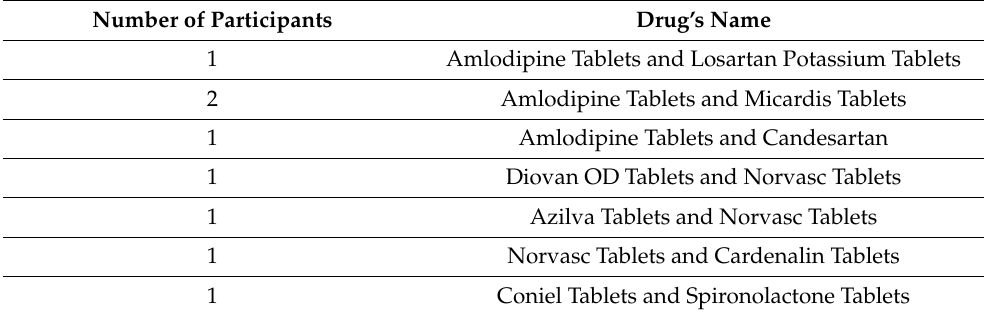
Table A2. List of two combinations of antihypertensive drugs.